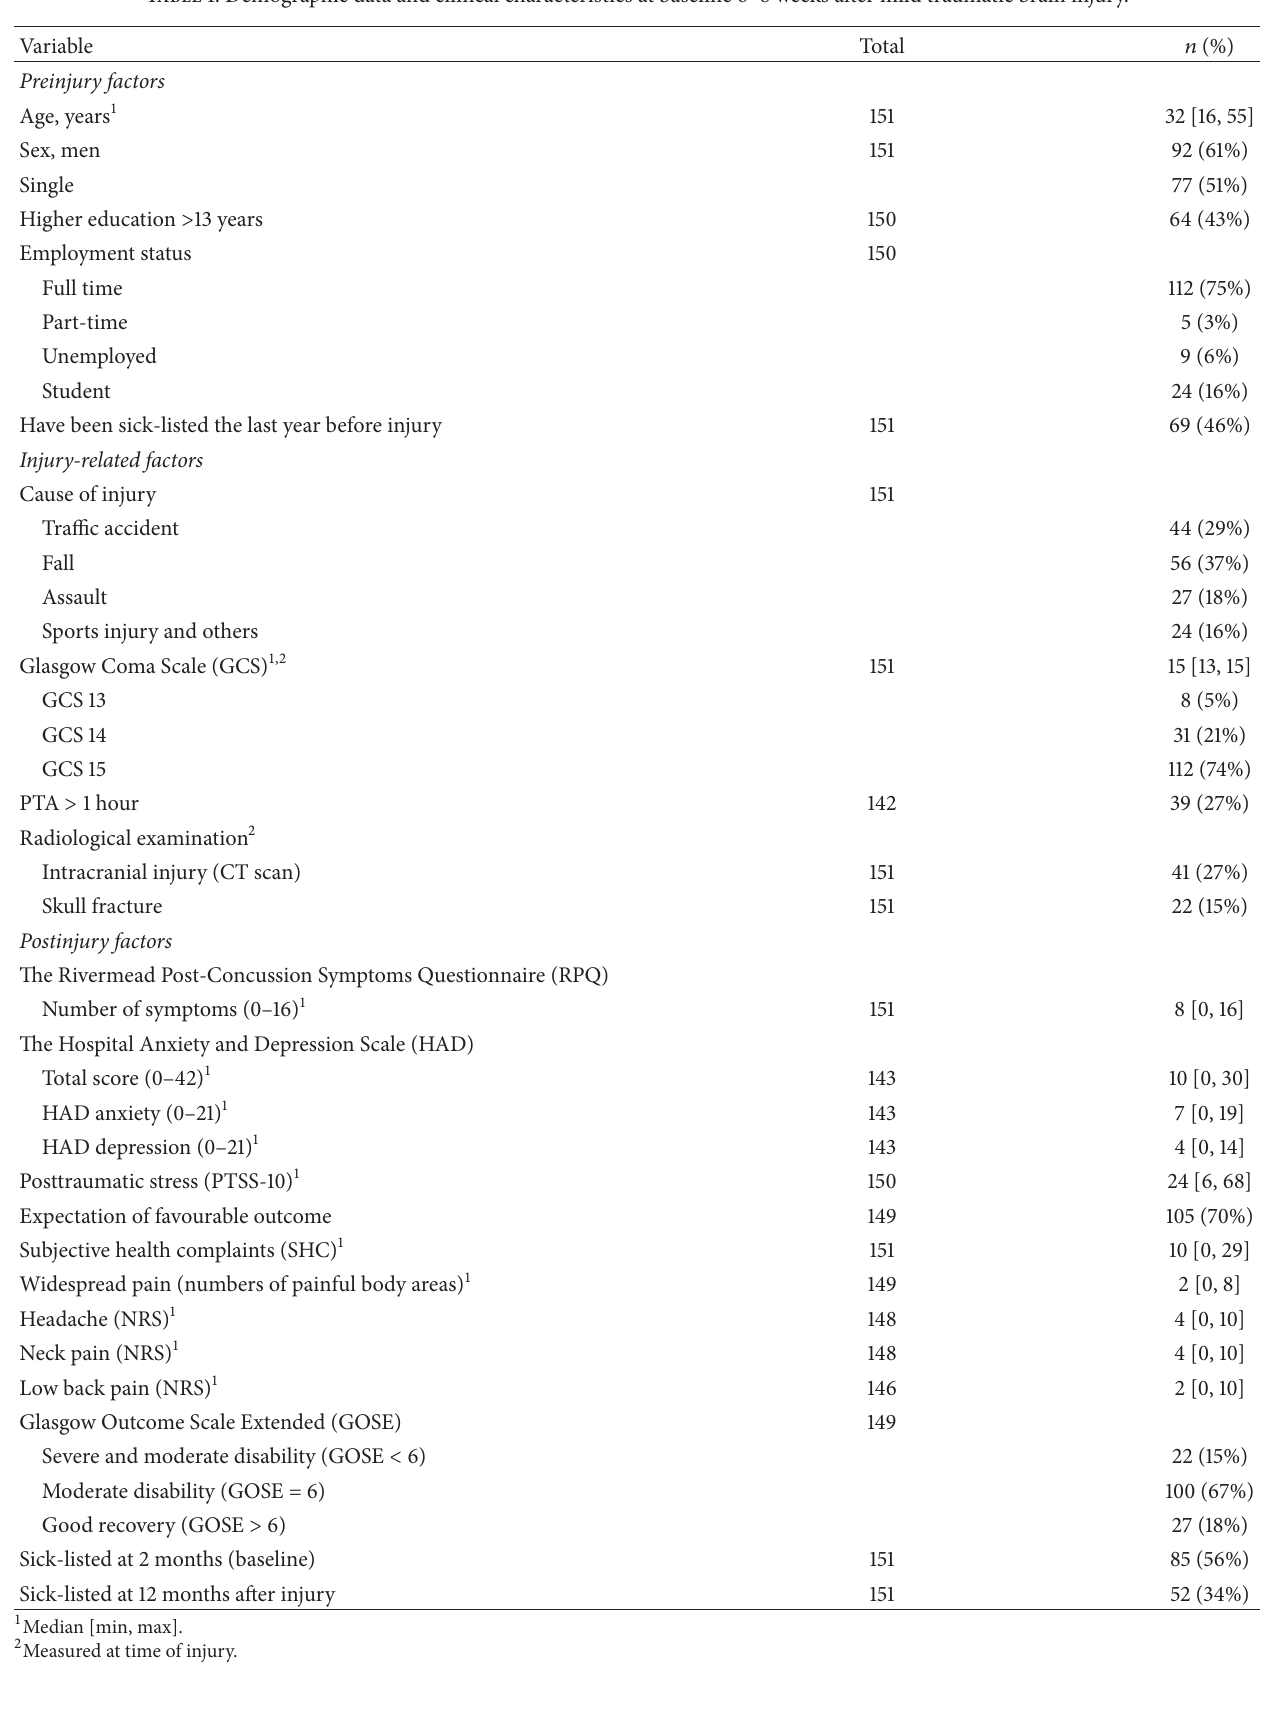
Table 1: Demographic data and clinical characteristics at baseline 6–8 weeks after mild traumatic brain